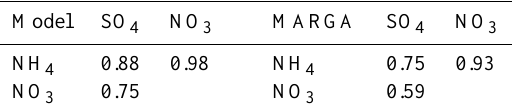
Fig. 2. Comparison of the measured seasonal cycle for nitrate, sulphate, ammonium, nitric acid and ammonia at Cabauw with 7km grid resolution estimates of the LOTOS-EUROS model for this location. Note that for easy interpretation the data have been organised as if it was a year from January–December. Hence, the monthly means of January–July 2008, are put before the period August–December 2007. 3 Table 2. Comparison of the correlation ( R ) between the SIA com- ponents in the LOTOS-EUROS model and in the MARGA data. Model SO